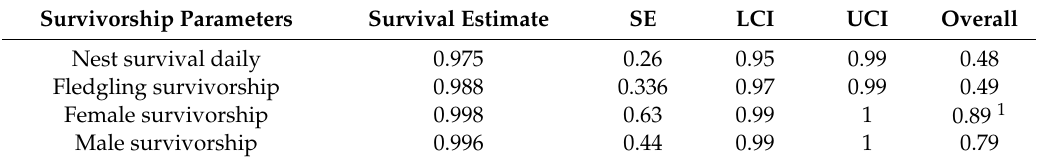
Table 5. Parameter estimates, standard error (SE), and lower (LCI) and upper (UCI) confidence intervals for daily survivorship and overall survival; 29 days for nests (n = 37), and 60 days for fledglings (n = 18) and adult male (n = 20) and female (n = 11) rusty blackbird survival in northern New Hampshire from